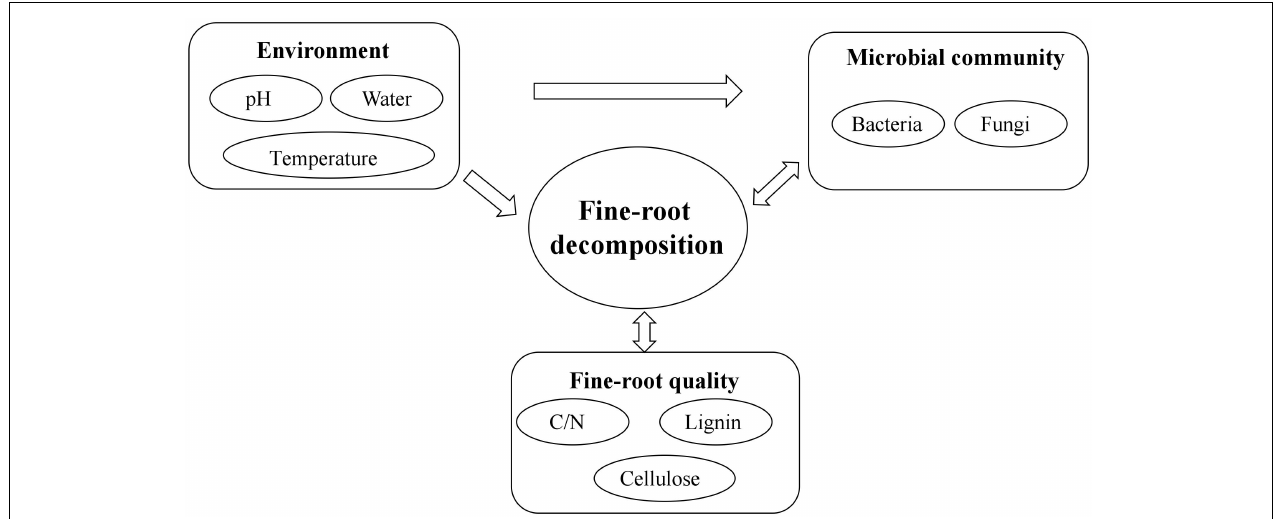
FIGURE 4 | Factors controlling fine-root decomposition and their